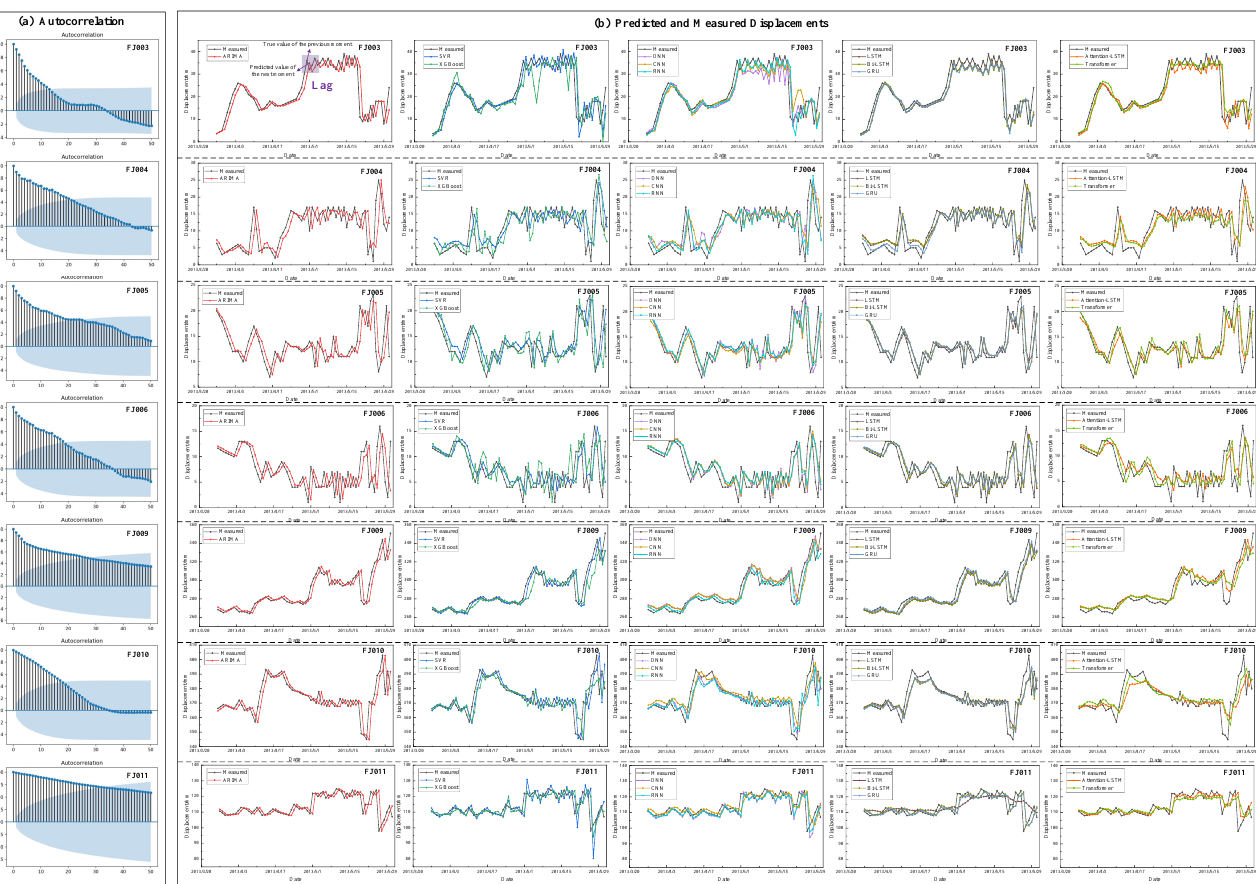
Figure 8. Predicted displacements and the autocorrelation functions of the seven monitoring points. ( a ) The autocorrelation functions; ( b ) the predicted and measured